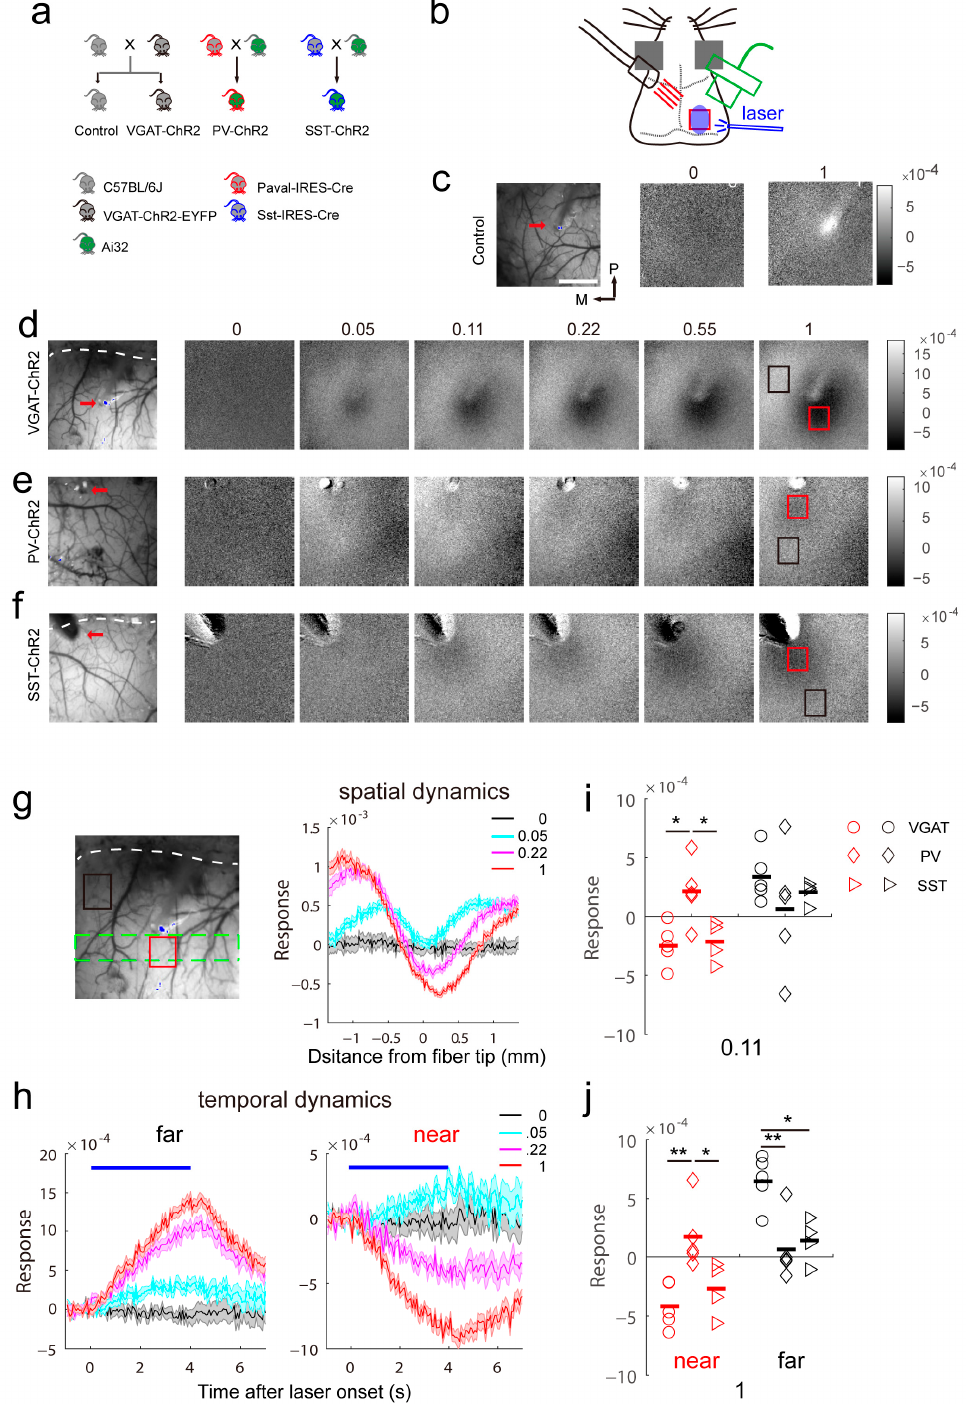
Figure 1. Differential local response induced by optogenetic stimulation of inhibitory neurons. ( a ) Mouse breeding strategy. ( b ) Schematic of intrinsic signal optical imaging and laser